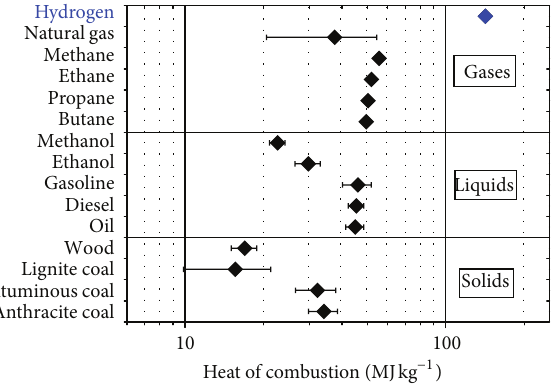
Figure 3: Heat of combustion on a gravimetric basis, shown for various gaseous, liquid, and solid fuels under standard conditions. The ranges of values were obtained by utilizing a multitude of sources [18, 28–38].